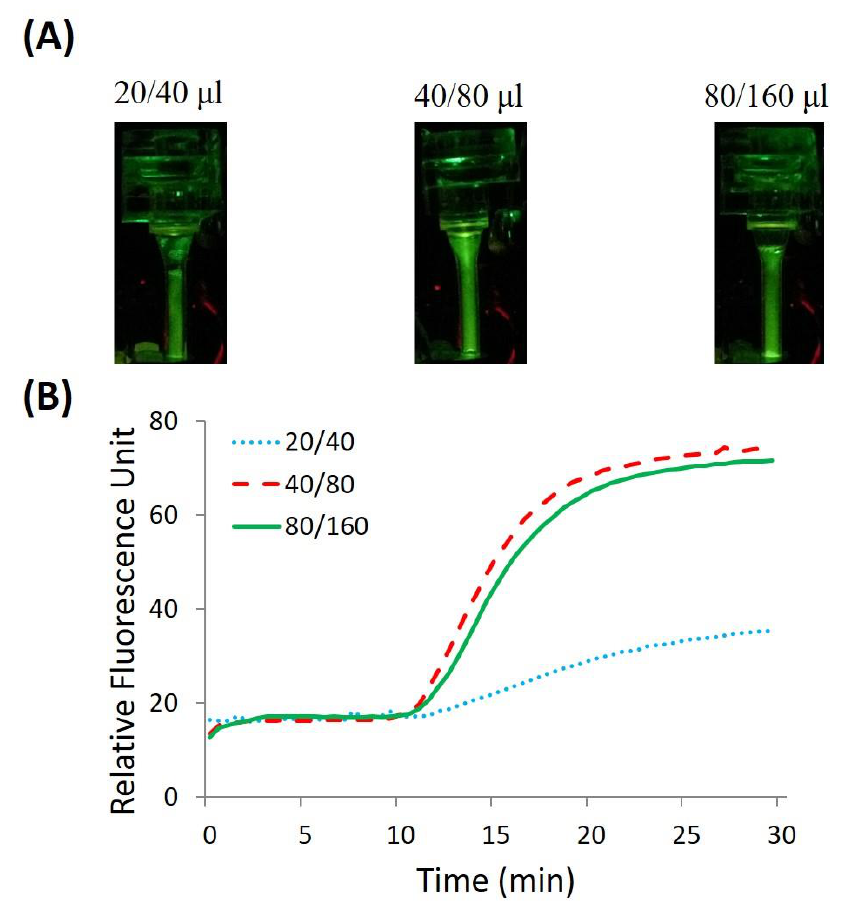
Figure 6. CPCR with H1N1 templates. In details: ( A ) end-point fluorescent images of amplicons with different wash options; ( B ) analyzed real-time fluorescence curves with different wash options, the solid line, dashed line, and dotted line, respectively, correspond to different wash options of 80/160 μL, 40/80 μL, and 20/40 μL of purification buffer/TE buffer.